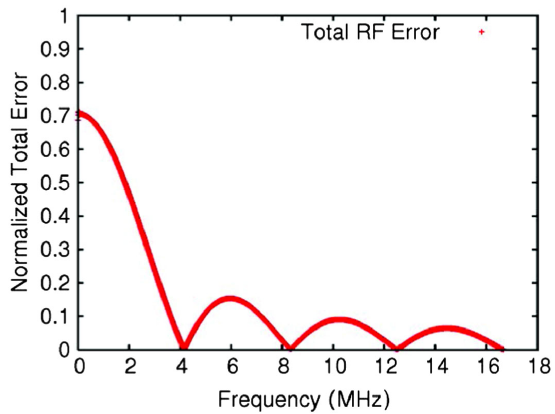
FIG. 3. Filtering factor of the ideal rf filling function vs rf phase jitter